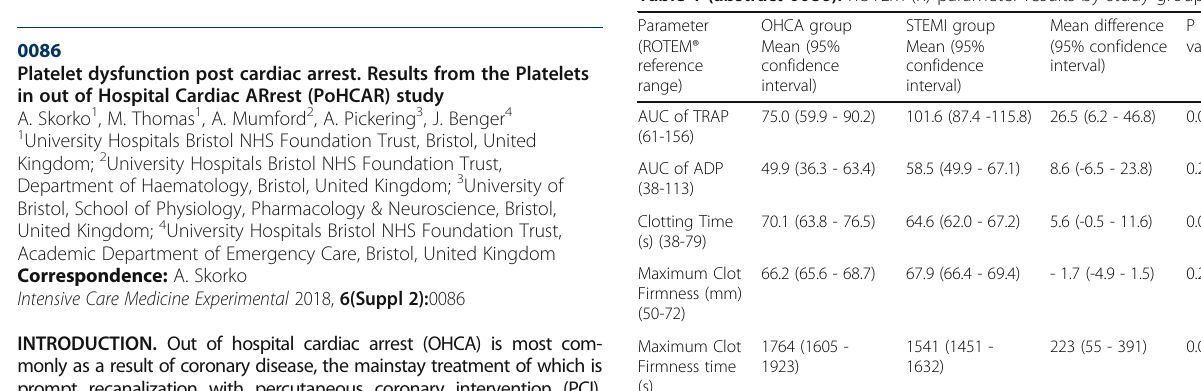
Table 1 (abstract 0086). ROTEM (R) parameter results by study